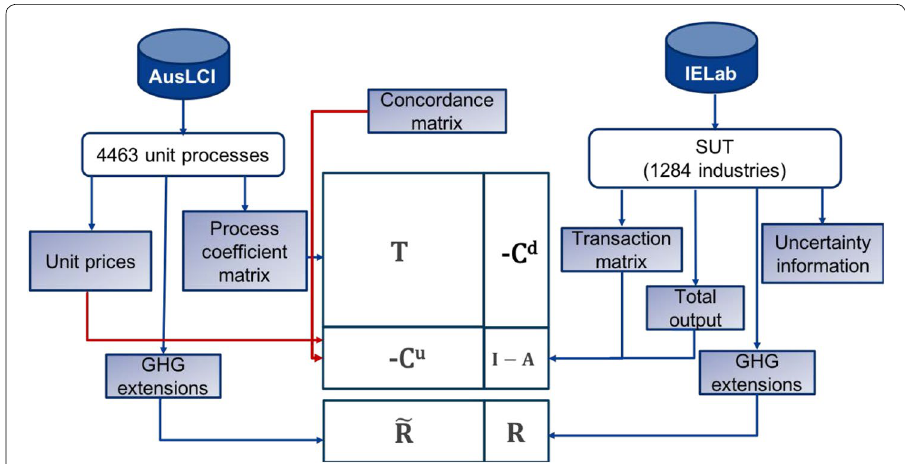
Fig. 2 Data sources and inputs used in this study. ( AusLCI Australian National Life Cycle Inventory Database; IELab Australian Industrial Ecology Virtual